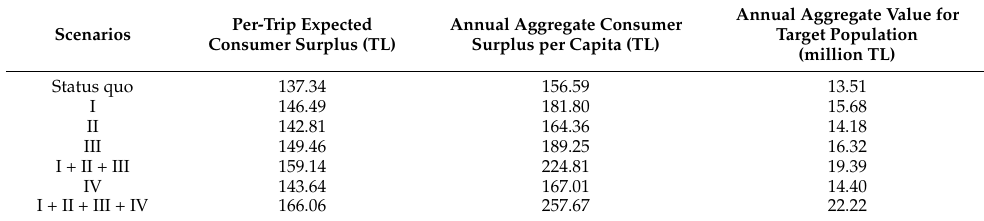
Table 5. The aggregate value estimates by the